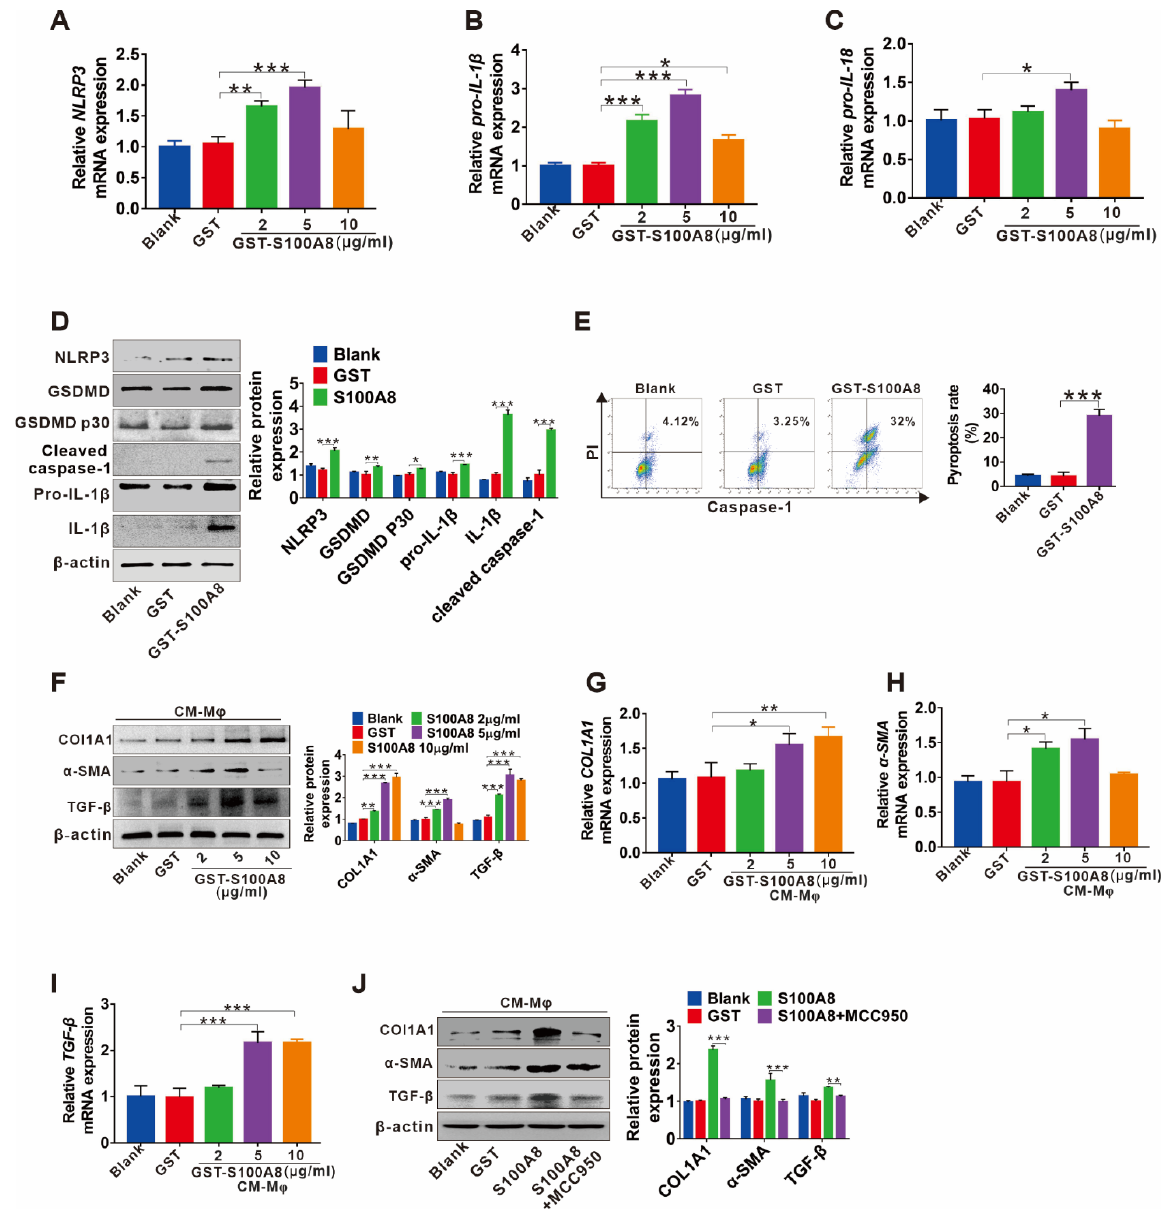
Figure 4. S100A8-mediated NLRP3 inflammasome-dependent pyroptotic macrophage death amplify the activation of human hepatic stellate cells. (A – C) The qRT – PCR analysis for the mRNA levels of NLRP3, pro-IL- 1β , and pro-IL-18 in THP-1 macrophages treated with 0, 2, 5 or 10 µg/mL rhS100A8 or 5 µg/mL GST for 24 h. (D) The protein levels of NLRP3, GSDMD, GSDMD P30, pro-IL- 1β, mature IL- 1β , and cleaved caspase-1 were detected by Western blot in THP-1 macrophages treated with 5 µg/mL GST or rhS100A8. The protein expression was quantified by densitometry and normalized to β -actin and are shown as fold changes relative to the GST group (right panel). (E) PI and active caspase-1 double staining of pyroptotic cell death by flow cytometry in THP-1 macrophages treated with 5 µg/mL GST or rhS100A8. (F – I) Western blot analysis (F) and qRT-PCR analysis (G – I) of COL1A1, α -SMA, and TGF- β in LX-2 cells exposed to CM from THP-1 macrophages that were treated with 0, 2, 5 or 10 µg/mL of rhS100A8 or 5 µg/mL GST. (J) Western blot analysis of COL1A1, α -SMA, and TGF- β in LX -2 cells exposed to CM from THP-1 macrophages that were treated with 5 µg/mL of rhS100A8 with or without 1 h of MCC950 pretreatment. The protein expression was quantified by densitometry and normalized to β -actin and are shown as fold changes relative to the GST group (right panel). * p < 0.05, ** p < 0.01, *** p < 0.001.